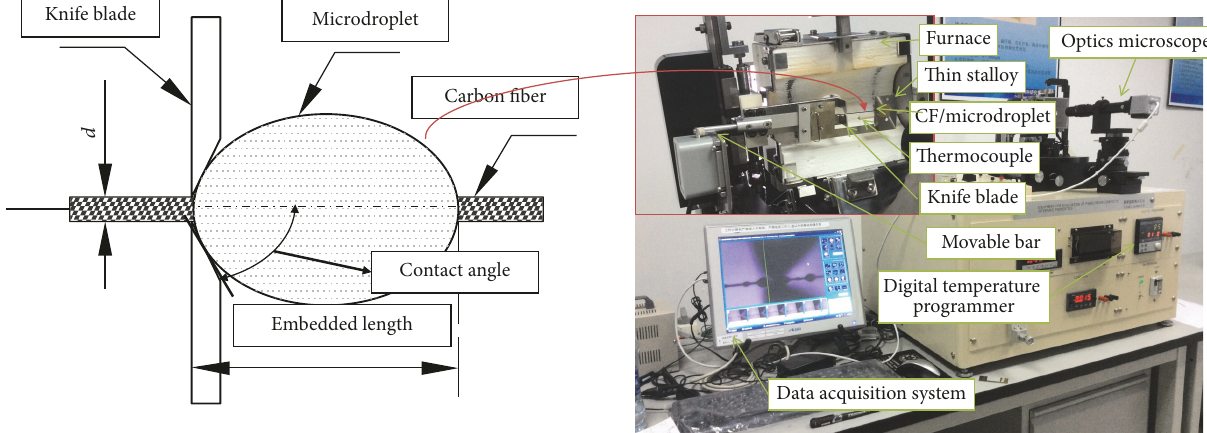
Figure 1: Temperature dependence HM410-microdroplet test